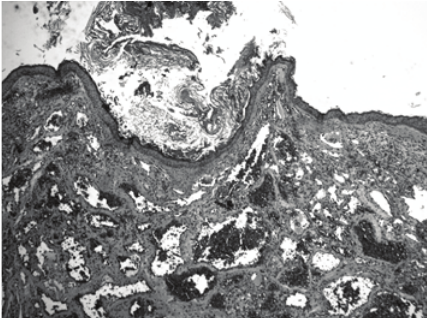
Figure 3: Cavernous hemangioma, HE, 50x. Histologic image of the tumours consisting in a well-defined proliferation of dilated tortuous vascular structures, closely adhering to each other, filled by erythrocytes in the lumen. They varied in size and were delimited by a single layer of flat endothelial cells. Superficially, the lesion was lined by hyperkeratotic squamous